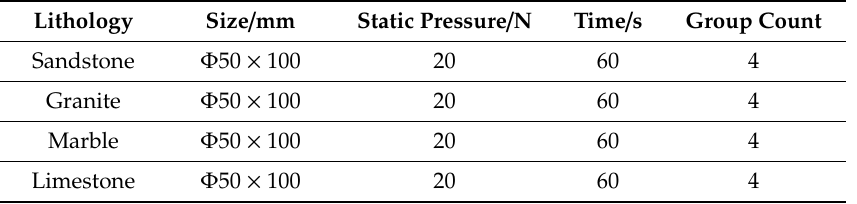
Table 2. Physical experiment